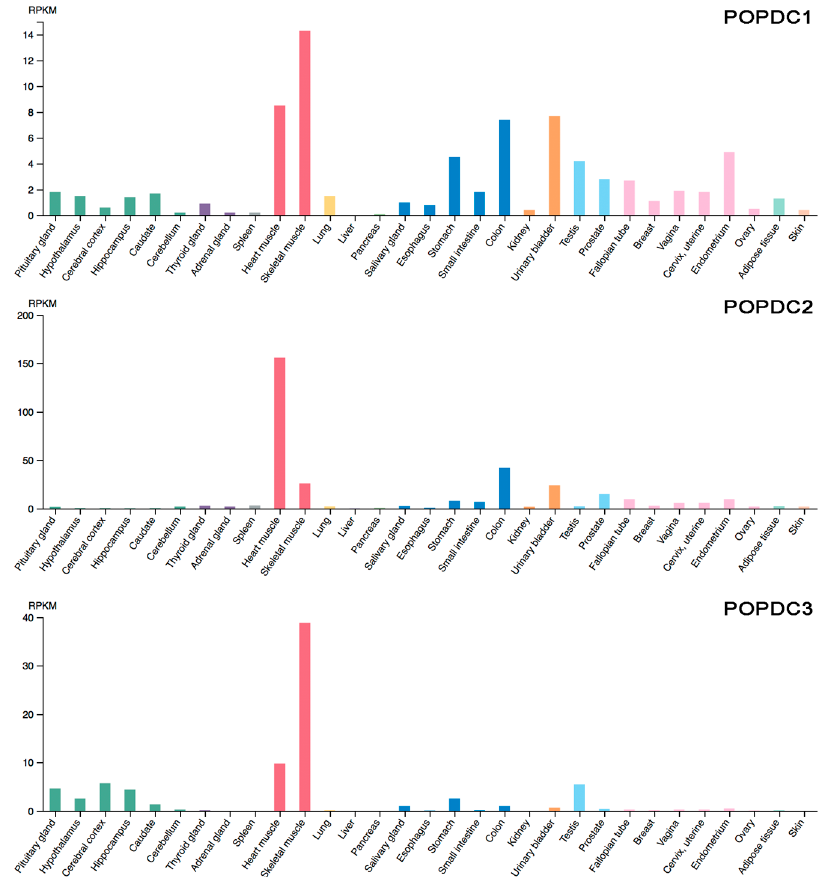
Figure 4. Expression of POPDC genes in the human body. RNA seq data of POPDC1 , POPDC2 and POPDC3 in human tissue. RNA expression is quantified as reads per kilogram per million mapped reads (RPKM). Data were copied from the Human Protein Atlas website [46–48].